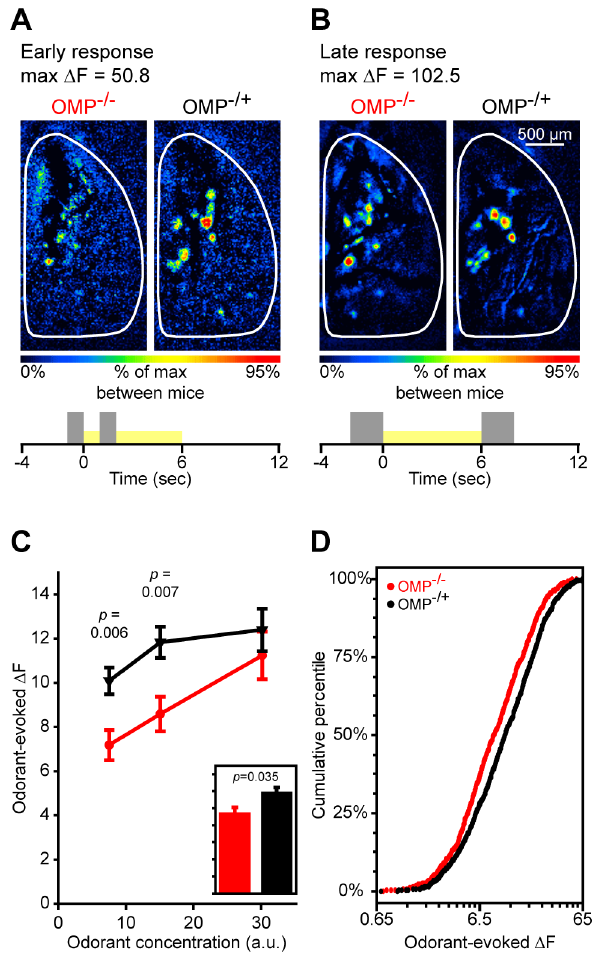
Figure 4. The evolution of odorant-evoked maps is slowed in OMP 2 / 2 mice. ( A ) Pseudocolored difference maps from an OMP 2 / 2 mouse ( left ) and an OMP 2 / + mouse ( right ) showing an early response evoked by 7.5 a.u. MV. ( B ) Late phase of the same responses shown in A . Trial summaries shown at the bottom of A and B indicate the subtractions that were made to generate early and late response maps, respectively. ( C ) Mean ( 6 SEM) odorant-evoked change in fluorescence ( D F) during the early response phase (see subtraction shown in A ) plotted as a function of odorant concentration. The overall group means shown in the inset , which is scaled to the y -axis of C , are averaged across all odors and concentrations. ( D ) Cumulative probability plot showing the distributions of early odorant-evoked D F values for populations of glomerular responses in OMP 2 / 2 mice and OMP 2 / + mice. D F distributions for each group are pooled across 3 concentrations of 4 test odorants. In C and D OMP 2 / 2 mice and OMP 2 / + mice are shown in red and black ,